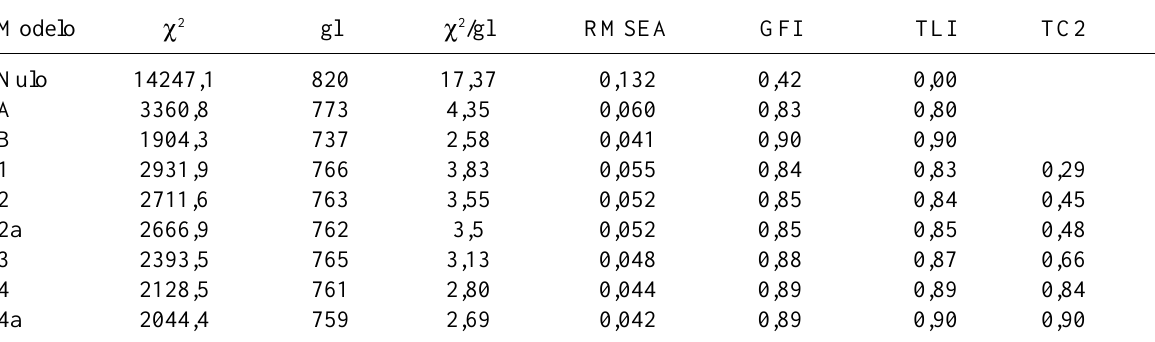
forçados a ser iguais para ambos os grupos. Os resulta- dos obtidos mostram que a hipótese da invariância nos